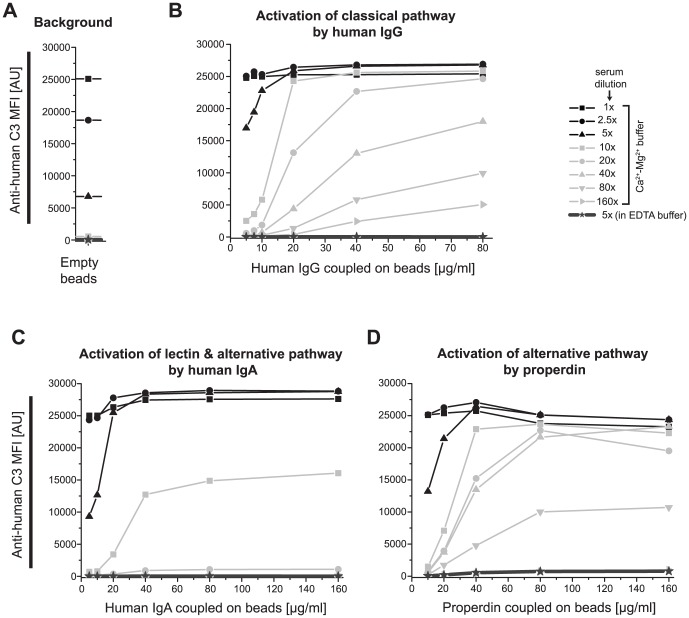
Dependence of complement activation on serum dilution rate.For measuring the background, classical, lectin & alternative and only alternative pathway activation, a serially diluted serum sample (1∶1–1∶160) was applied to empty, human IgG, human IgA and properdin-coupled beads, respectively. The assay buffer for serum dilution contained either Ca2+-Mg2+, which promotes complement activation, or EDTA, which blocks complement activation. Complement activation-driven C3 fragment deposition on beads was detected by PE-conjugated anti-human C3 antibody. Plots display for each serum dilution the respective median fluorescence intensity (MFI) value against varying concentrations of human IgG, human IgA and properdin coupled on beads. AU - arbitrary units